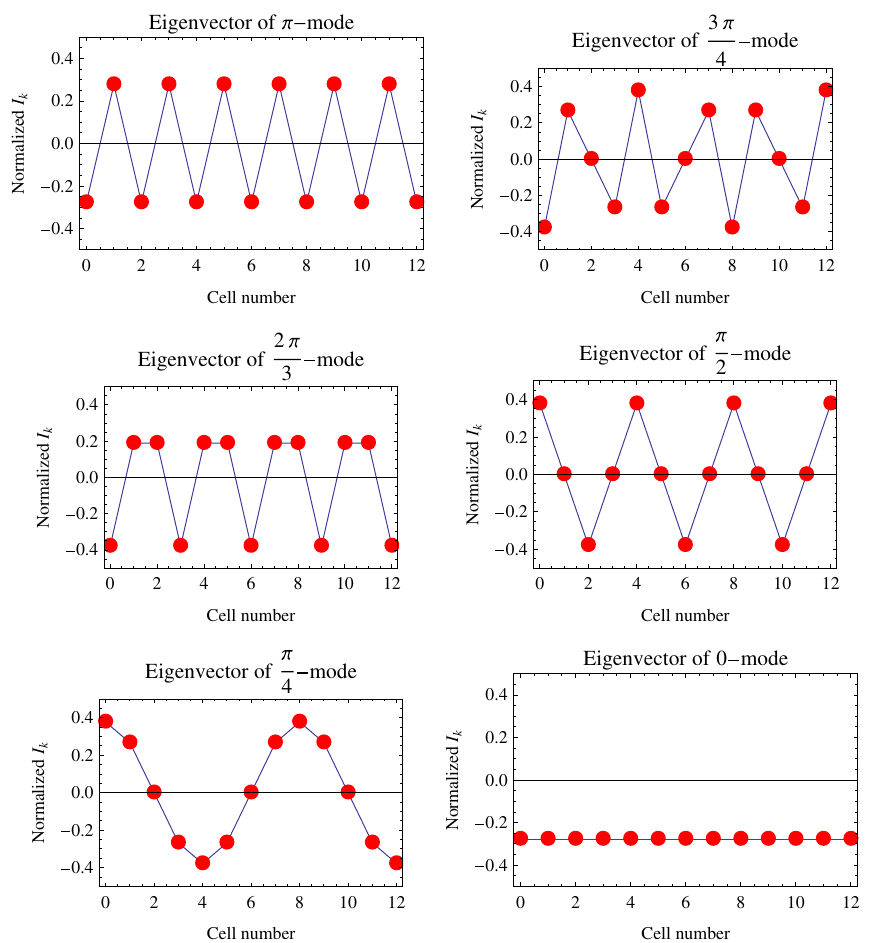
FIG. 6 (color online). The normalized eigenvectors of U 0 ð κ 1 ; 0 Þ plotted in blue and the ansatz plotted as red filled dots for a few modes. It is clear that the ansatz matches the numerically calculated eigenvectors